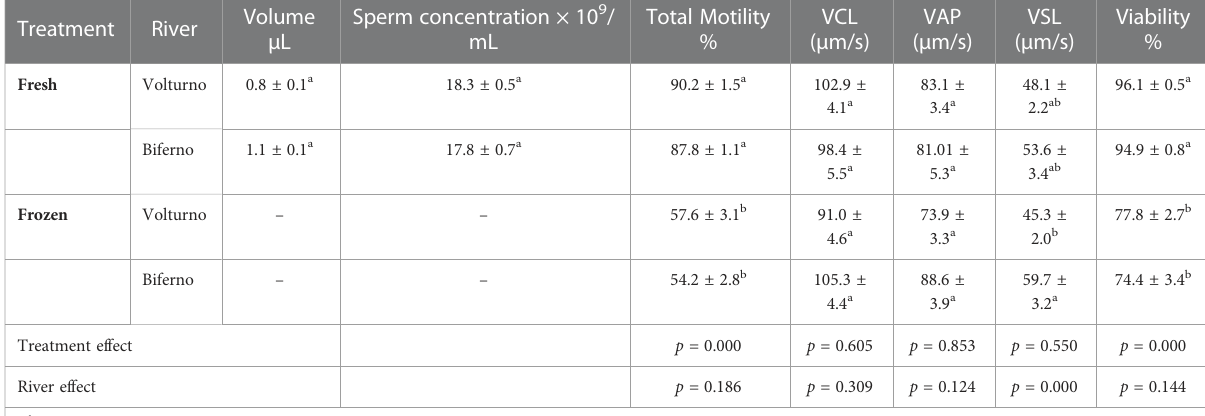
TABLE 3 Quality of fresh and frozen semen (means ± SEM) in brown trout population inhabiting Biferno and Volturno river (Molise region, Italy).